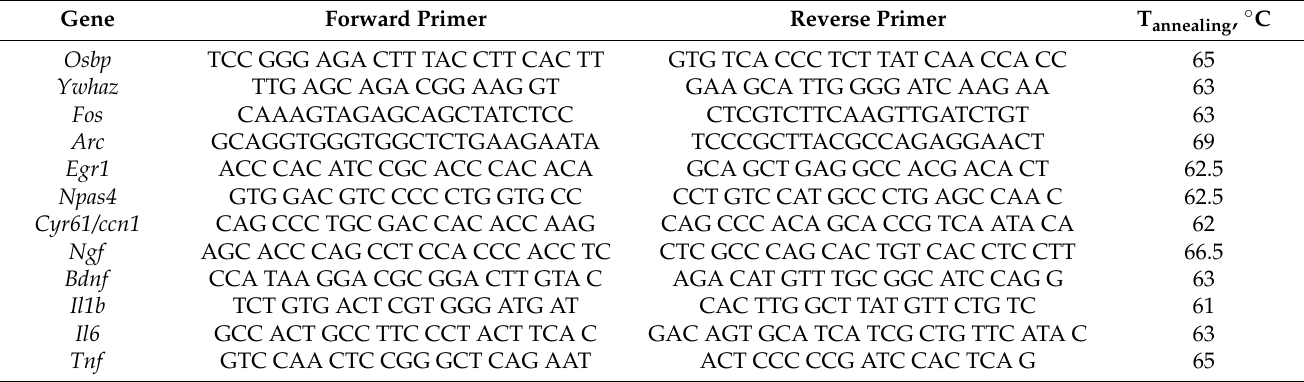
Table 1. Primer sequences for